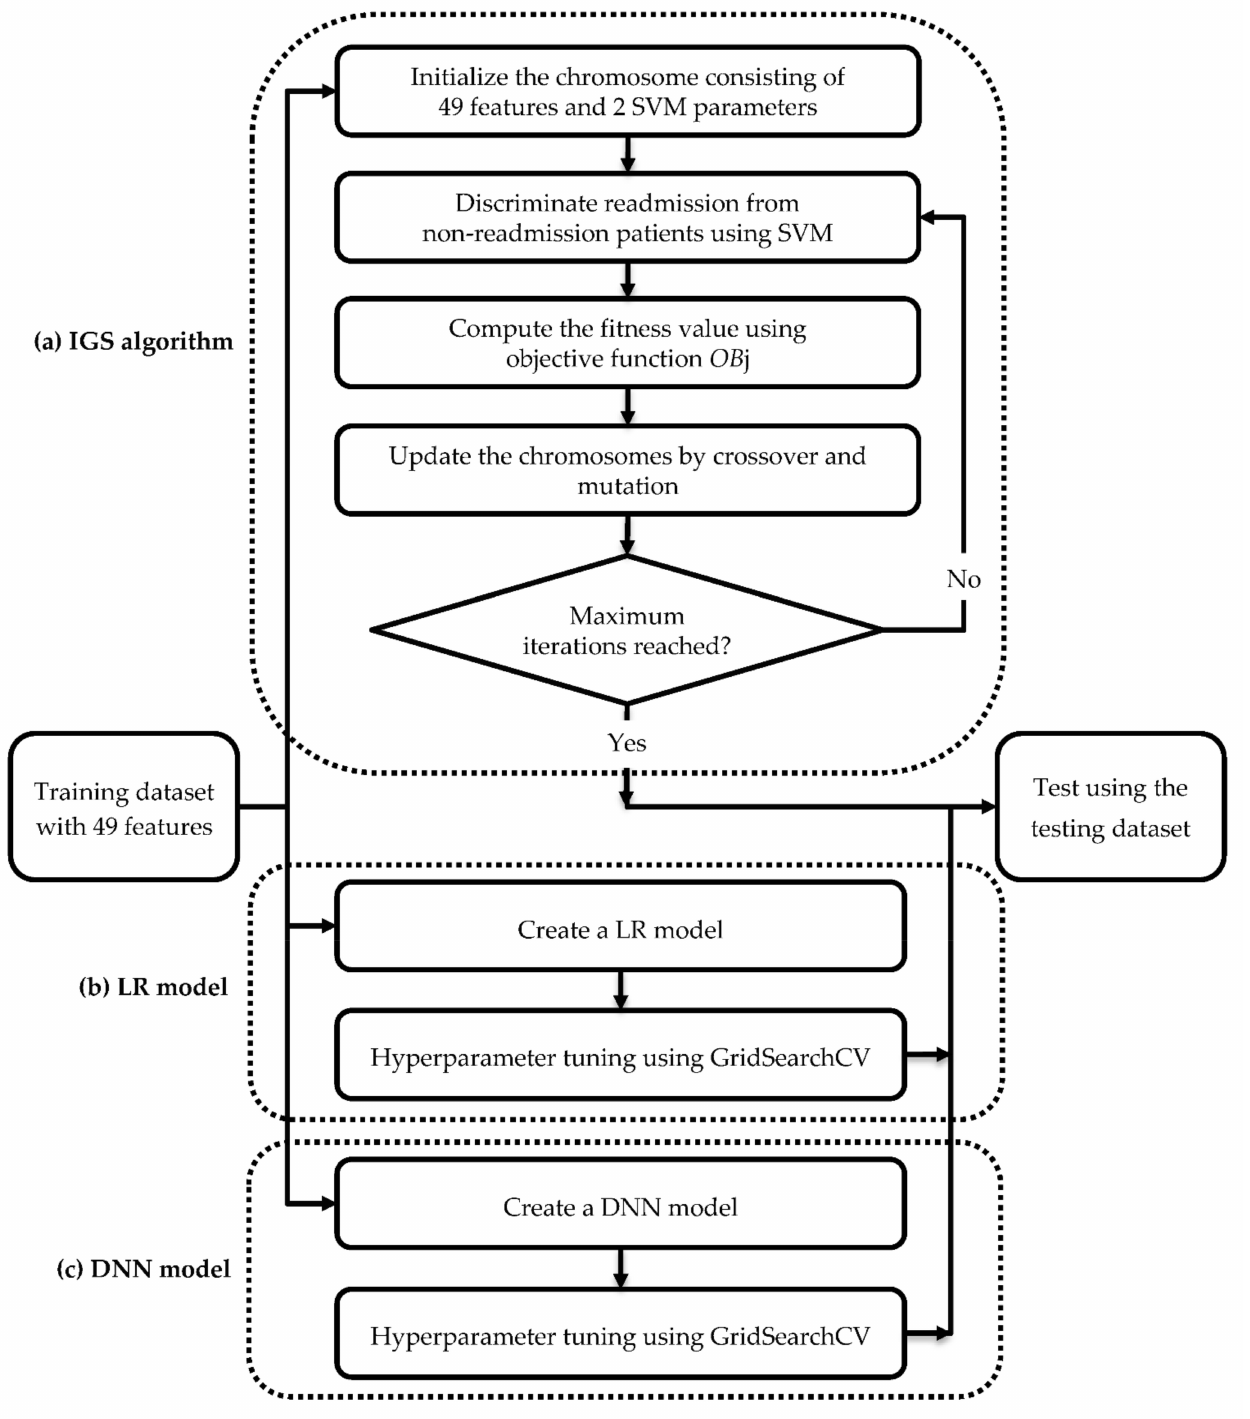
Figure 2. Optimization procedures of ( a ) IGS, ( b ) LR, and ( c ) DNN